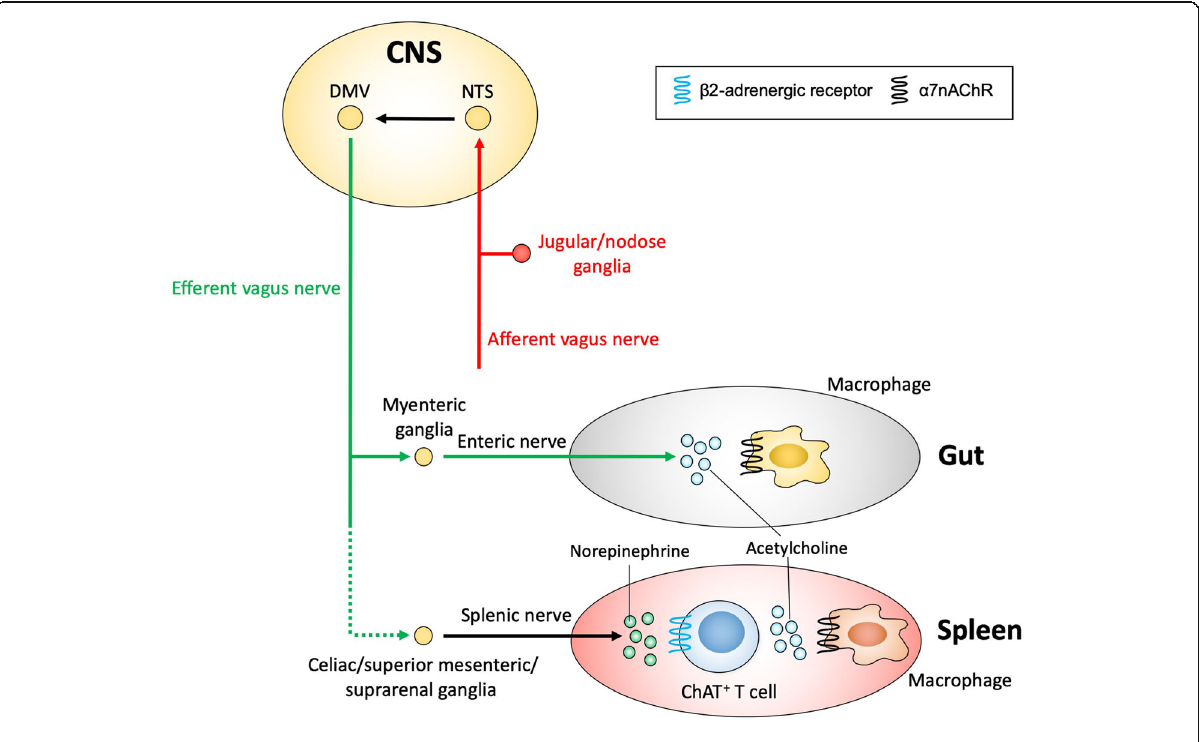
Fig. 1 The inflammatory reflex. The inflammatory reflex is triggered when the afferent vagus nerve senses inflammatory products through the receptors. The nerve activity is relayed through the central nervous system (CNS) to the efferent vagus nerve. The original pathway involves the splenic nerve although a direct connection between the efferent vagus nerve and the splenic nerve is still controversial. Activated splenic nerves release norepinephrine from their terminals, which interacts with β 2-adrenergic receptors expressed on the choline acetyltransferase (ChAT)- positive T cells in the spleen, causing acetylcholine (ACh) release from this specific T cell subpopulation. ACh binds to α 7 nicotinic acetylcholine receptors ( α 7nAChRs) expressed on macrophages residing in close proximity to ChAT-positive T cells, resulting in suppression of proinflammatory cytokine production (e.g., TNF α ) by macrophages and alleviated inflammation in many pathological settings (e.g., endotoxemia, acute kidney injury). Recent studies also suggested that a direct interaction between cholinergic enteric neurons and gut resident macrophages via ACh had an anti-inflammatory effect. DMV, dorsal motor nucleus of the vagus; NTS, nucleus tractus